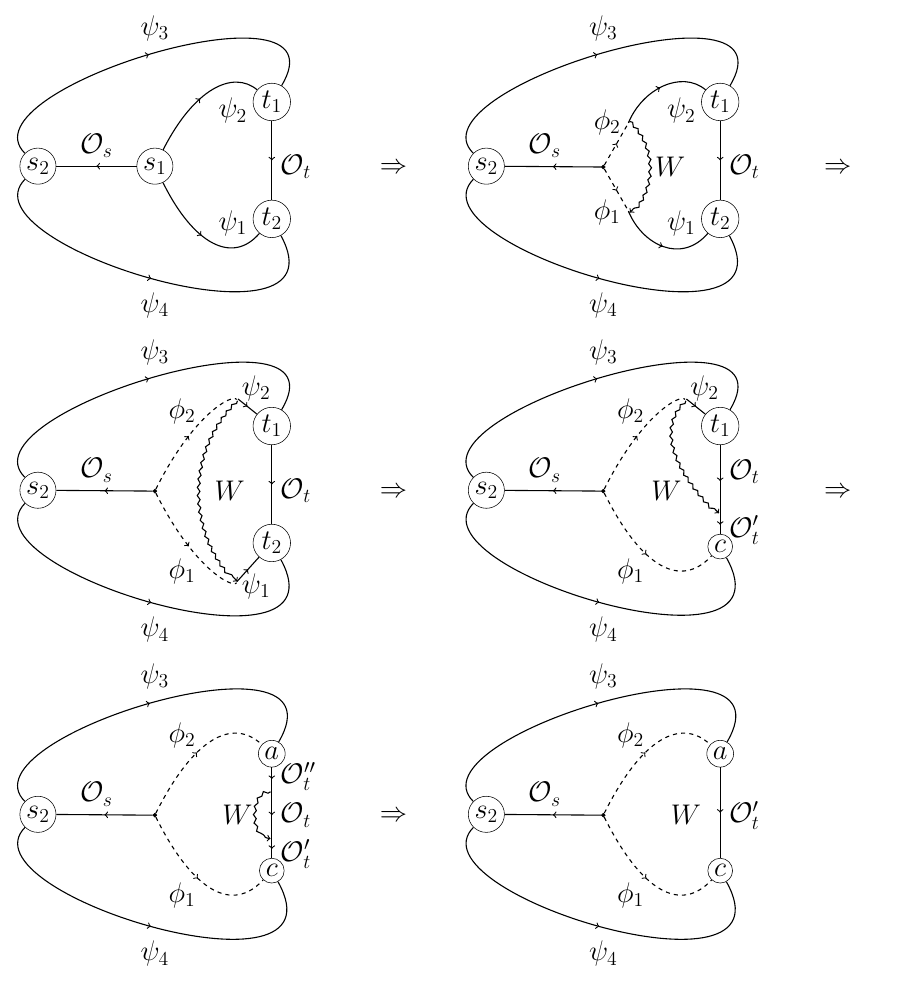
Figure 2 . Step by step diagrammatic illustration for the decomposition of 6 j symbol of four external fermions, , in terms of 6 j symbols of two external fermions and two external h i